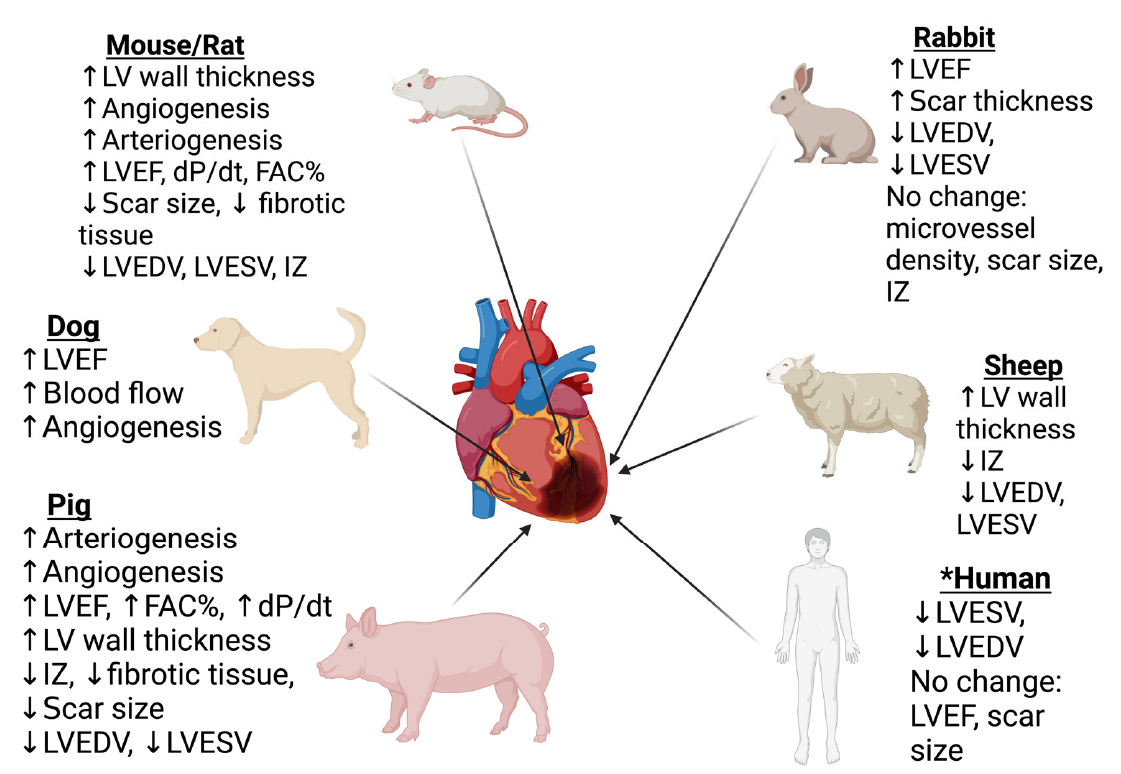
Figure 3. Successful implementation and effects of intelligent hydrogels in animal and human studies. Small animal models included in this article are rodents and rabbits. Large animal models include sheep, dogs, and pigs. Outcome measures of contractility include LV (left ventricle) wall thickness, LVEF (left ventricle ejection fraction), dP/dt (change in LV pressure gradient over time), and FAC% (fractional area change percentage). Measures of ventricular dilation are LVEDV (left ventricular end-diastolic volume) and LVESV (left ventricular end-systolic volume). Changes in blood supply metrics are angiogenesis, arteriogenesis, microvessel density, and blood flow. Quantifiers of healing include fibrotic tissue/fibrosis, scar size, and scar thickness, as well as ANP (atrial natriuretic peptide) and BNP (B-type natriuretic peptide). * Human studies are limited to simple, natural non-stimuli responsive